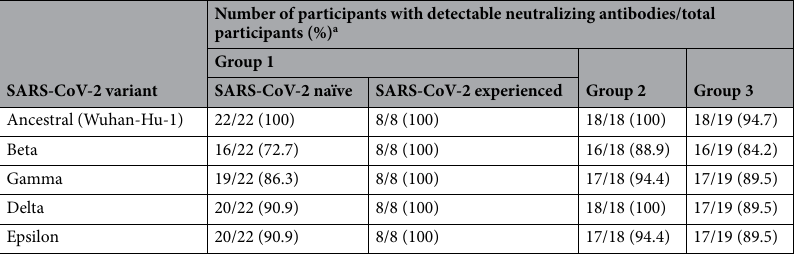
Table 1. Detectable neutralizing antibodies against different SARS-CoV-2 variants across study groups. a Group 1, nursing home residents fully vaccinated with the Comirnaty vaccine; Group 2, healthy individuals fully vaccinated with the Comirnaty vaccine; Group 3, unvaccinated, COVID-19 recovered individuals that required hospitalization in internal medicine or intensive care units.